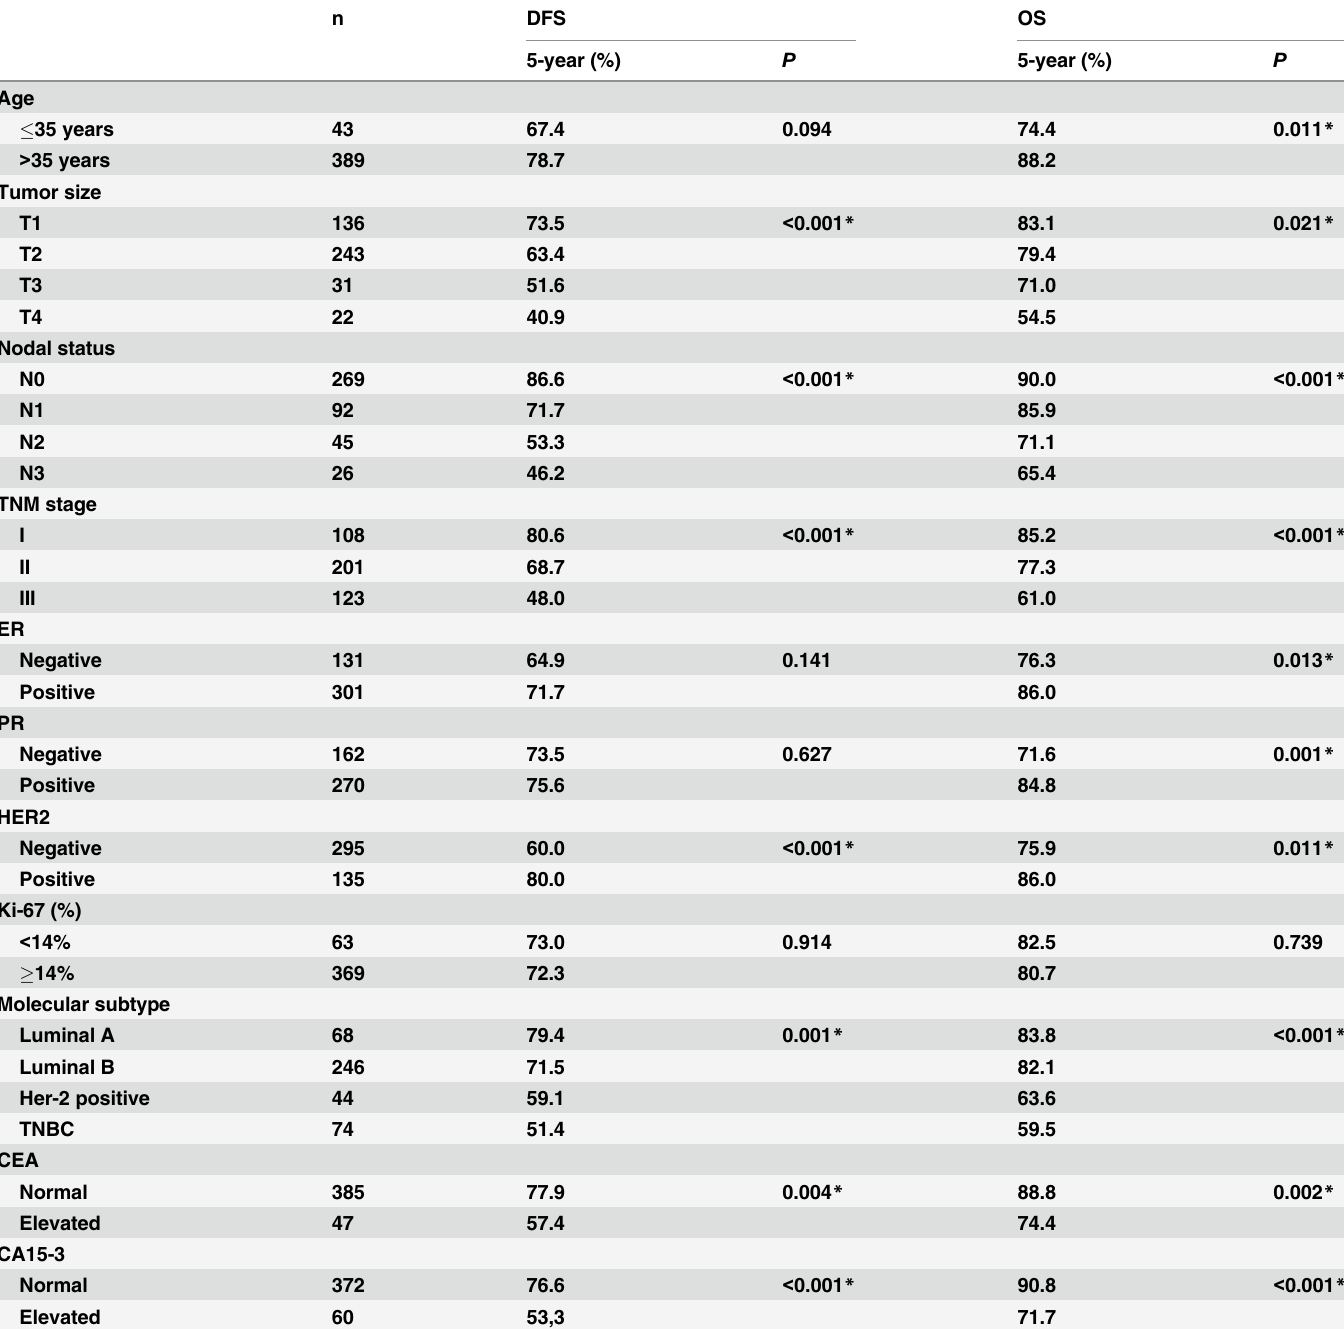
Table 2. Univariate analysis of prognostic factors for survival time of breast cancer